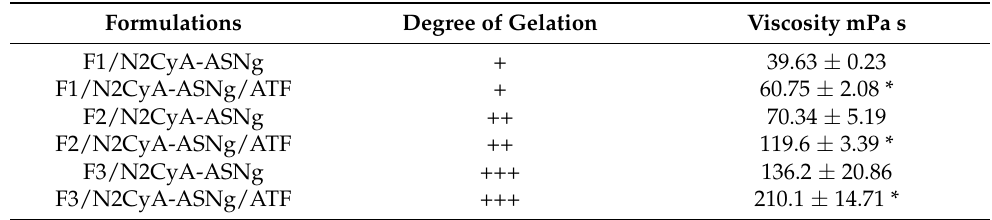
Figure 3. Picture of in situ gelling systems (F1–F3) containing N2 nanomicelles, Fx/CyA-ASNg ( left ) and Fx/CyA-ASNg/ATF (30:7, v / v ) ( right ). Table 5. Rheological parameters of GG-LA formulations before and after mixing with ATF (30:7 volume ratio) (mean ± SD, n = 3).